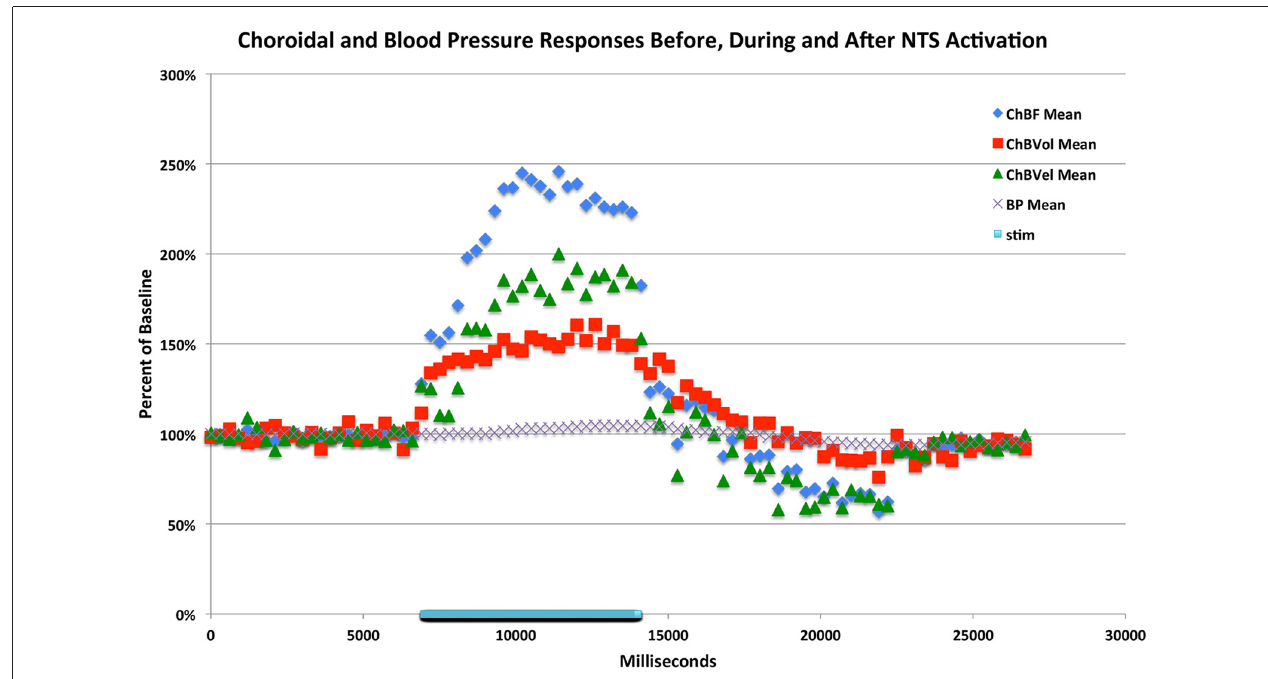
FIGURE 7 | Graph showing the time course of the mean ChBF, ChBVol, ChBVel and ABP responses to stimulation at effective anodal NTS sites ( n = x ). The blue bar marks the stimulation period. Each data point is the mean for a 333 ms interval, and ChBF, ChBVol, ChBVel and ABP responses are all expressed as percent of basal. The rapid ChBF increases are driven by rapid increases in both ChBVel and